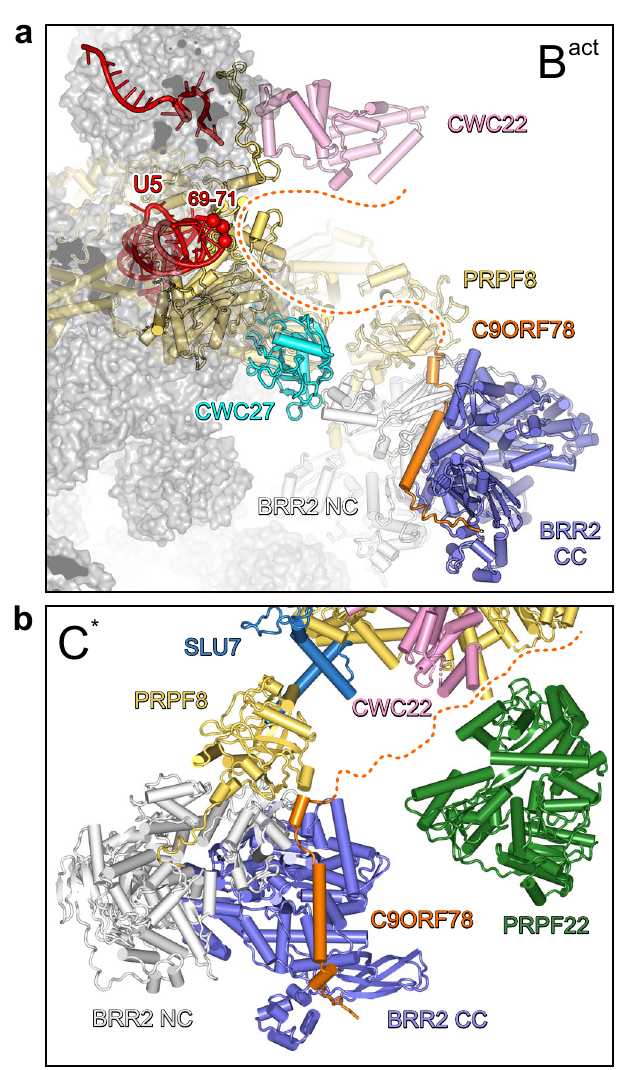
Fig. 8 Putative C8ORF78 neighborhoods in spliceosomal complexes. a Model for the positioning of C9ORF78 in the B act complex, suggesting how C9ORF78 may contact its putative interactors U5 snRNA IL1 (red spheres), CWC22 (cyan), and CWC27 (pink). The BRR2 HR -PRPF8 Jab1 - C9ORF78 structure was aligned with a cryoEM structure of the spliceosomal B act complex (PDB ID 5Z56) according to the common parts of BRR2 HR /BRR2. The 231 C-terminal C9ORF78 residues that are not visible in the BRR2 HR -PRPF8 Jab1 -C9ORF78 cryoEM map are indicated by a dashed line. b Model for the positioning of C9ORF78 in the C* complex, suggesting how C9ORF78 may contact its putative interactors PRPF22 (green) and CWC22 (pink). SLU7, sky blue. The BRR2 HR -PRPF8 Jab1 -C9ORF78 structure was aligned with a cryoEM structure of the spliceosomal C* complex (PDB ID 5XJC) according to the common parts of BRR2 HR /BRR2. The 231 C-terminal C9ORF78 residues that are not visible in the BRR2 HR -PRPF8 Jab1 - C9ORF78 cryoEM map are indicated by a dotted